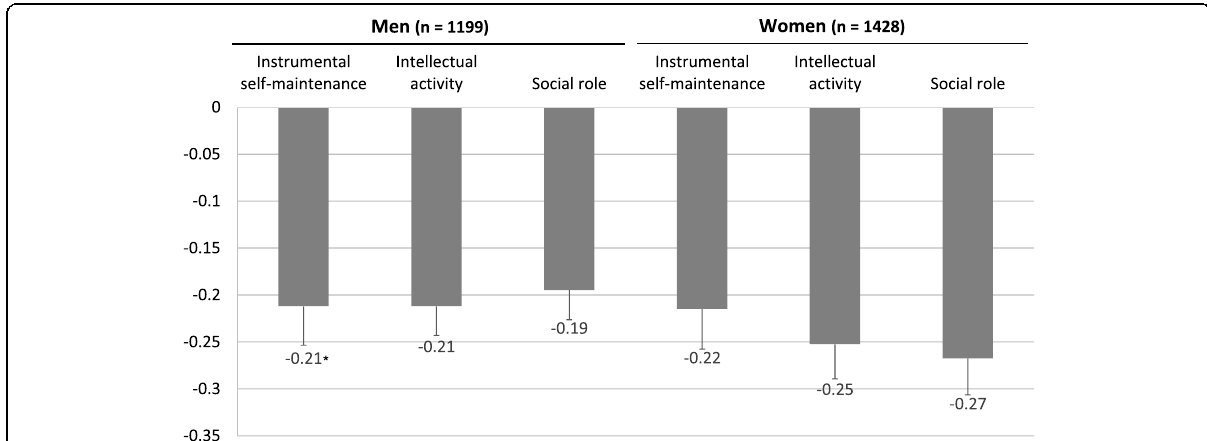
Fig. 2 Mean decrease score of the three subcategories of the Tokyo Metropolitan Institute of Gerontology Index of Competence (TMIG-IC) in those living with child and his/her spouse. *Mean and standard